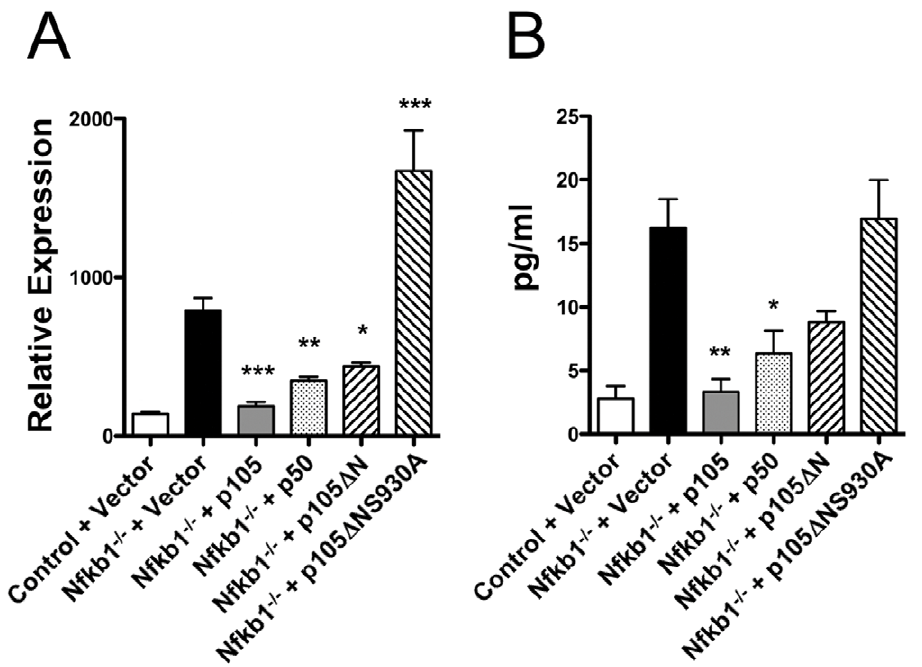
proteins 2 hours after stimulation with LPS. N=6–9 individual mice per group. B) Concentration of IFN- b in the supernatant of BMDM as determined by ELISA 12 hours after stimulation with LPS. N=6 mice per group.